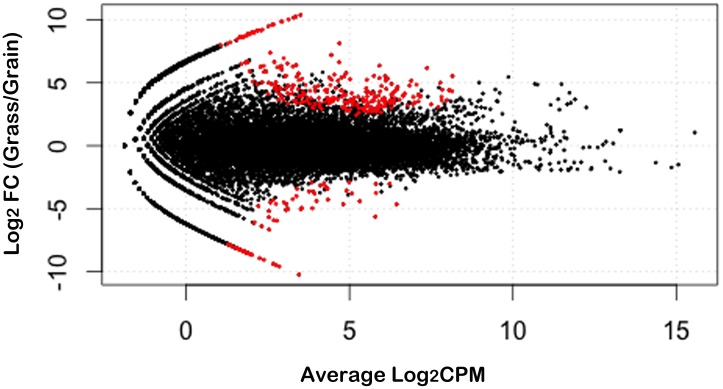
Differentially expressed rumen genes between grass-fed and grain-fed steers.MA-plot obtained from two independent biological replicates for FDR < 0.1. The red points refer to the genes with differential expression. The ordinate represents log2 fold change. CPM means counts per million.